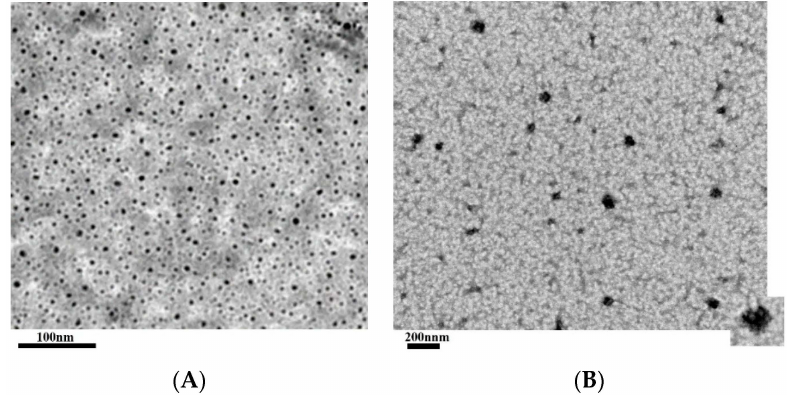
Figure 1. TEM images of ( A ) HA nanoparticles and ( B ) HA/SNL25 aggregates.